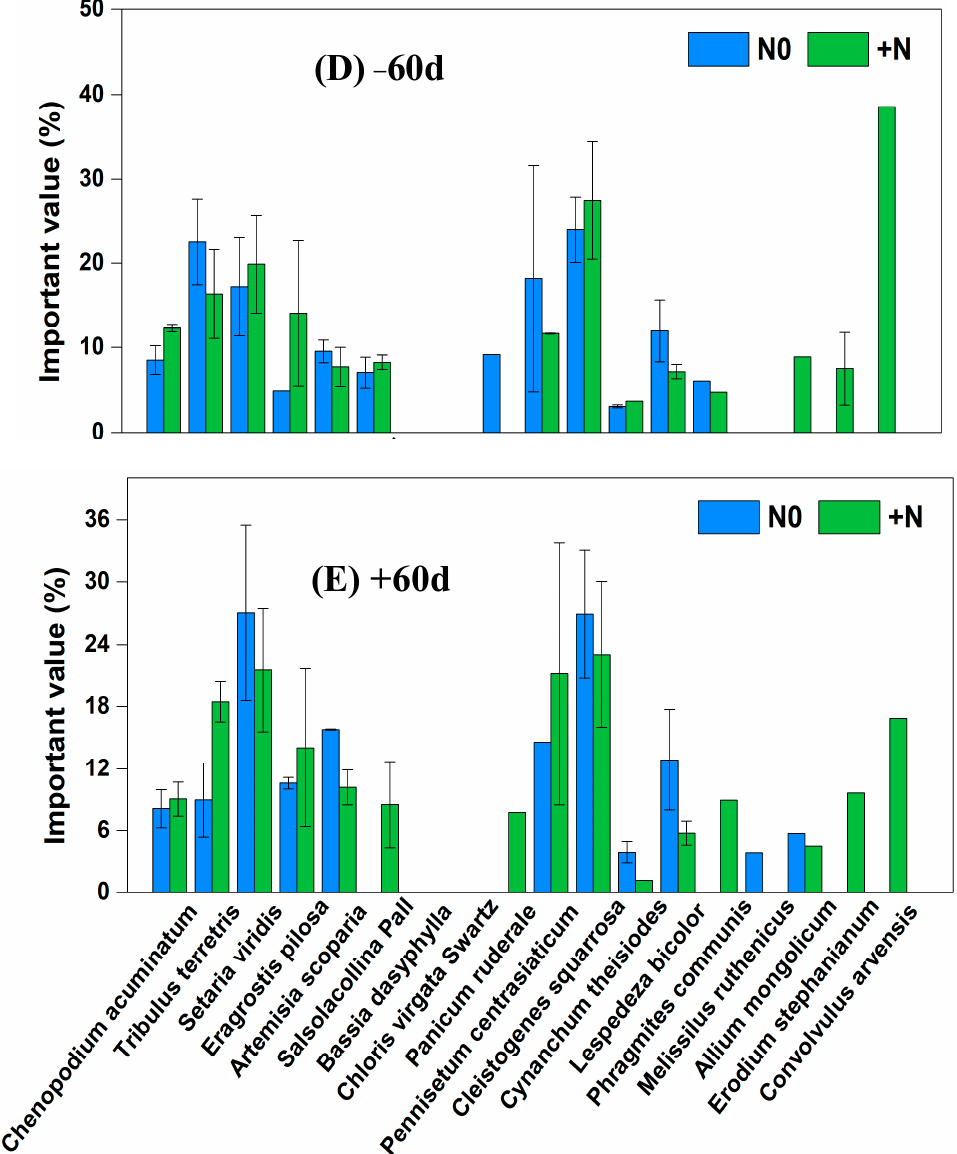
Figure 4. Changes of important values of vegetation in the sandy grassland under rainfall changes and nitrogen addition under fencing. Note: N0 is no nitrogen; +N is nitrogen addition.